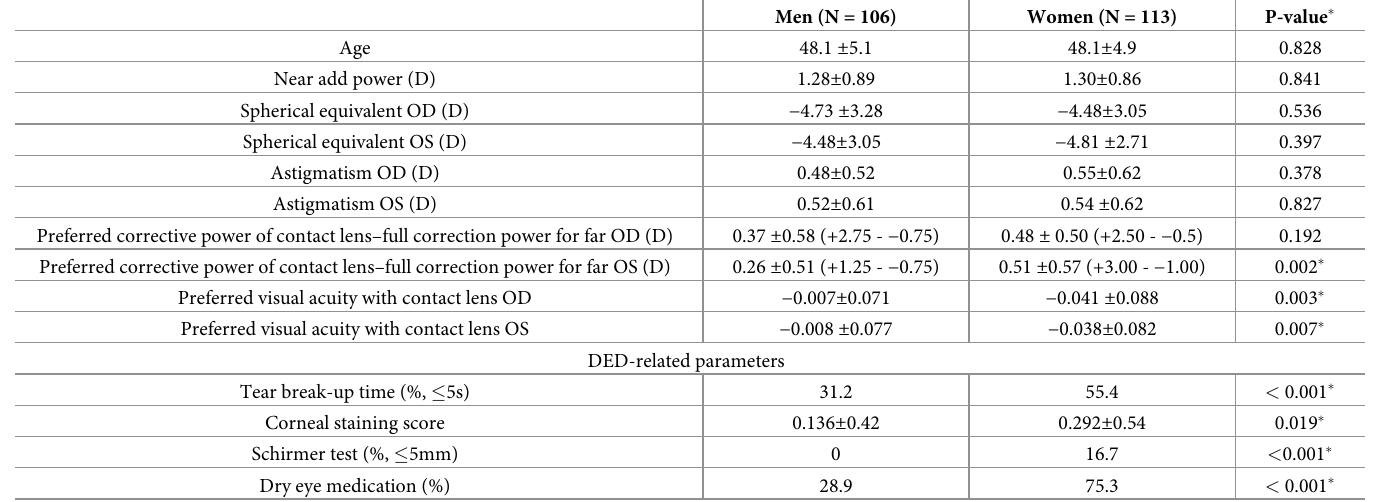
Table 3. Refraction, near add power, and dry eye-related parameters in men and women.